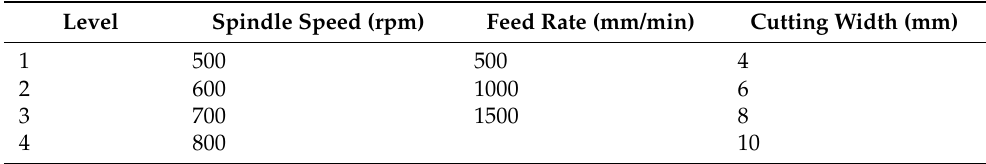
Table 4. The relevant parameters used in orthogonal experiments.